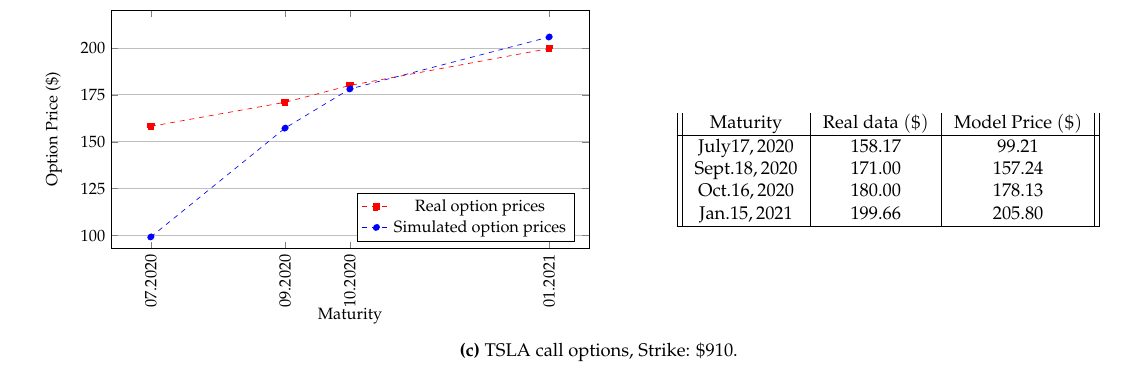
Figure 1. Numerical experiments for the Esscher method.